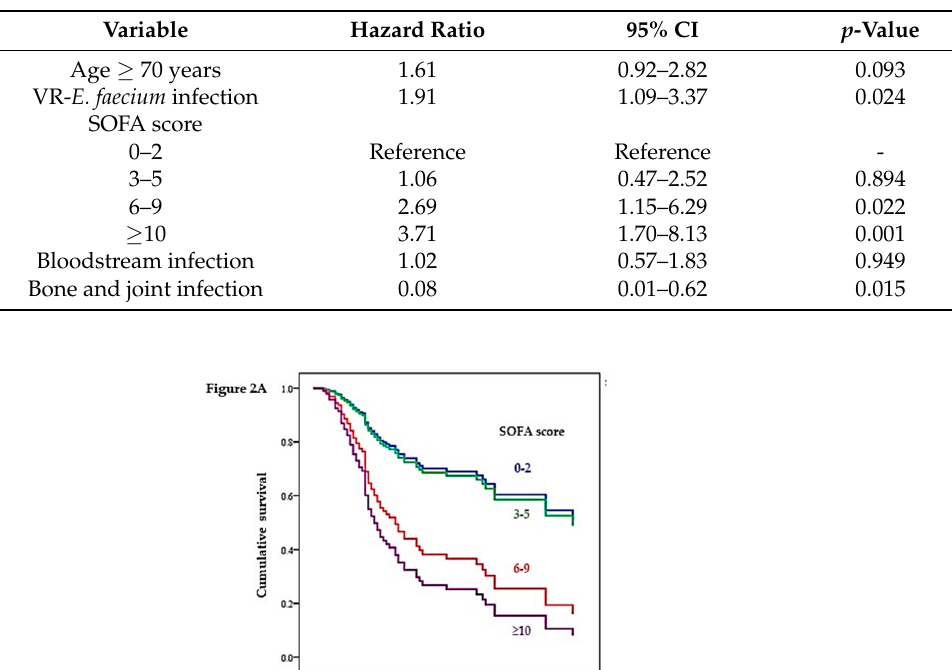
Table 4. Multivariate Cox proportional hazard regression analysis of 90-day survival among patients with E. faecium infections ( n = 145).